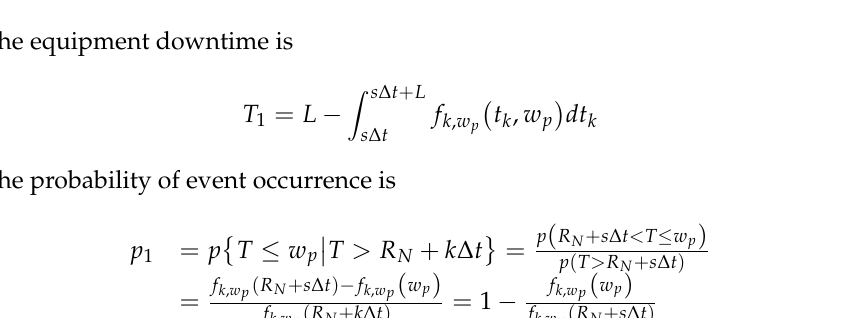
Figure 3. Preventive replacement and spare parts ordering process 1.